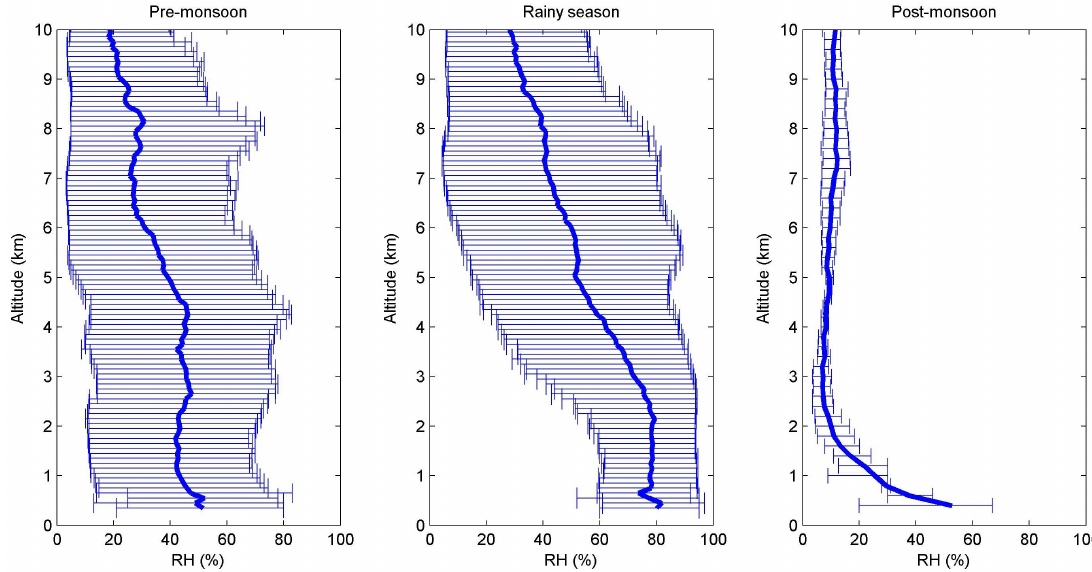
Fig. 13. Seasonal averaged RH-profiles from soundings at New Delhi airport during 2008 for the same time periods the lidar data was available. The 10th and 90th percentiles are also